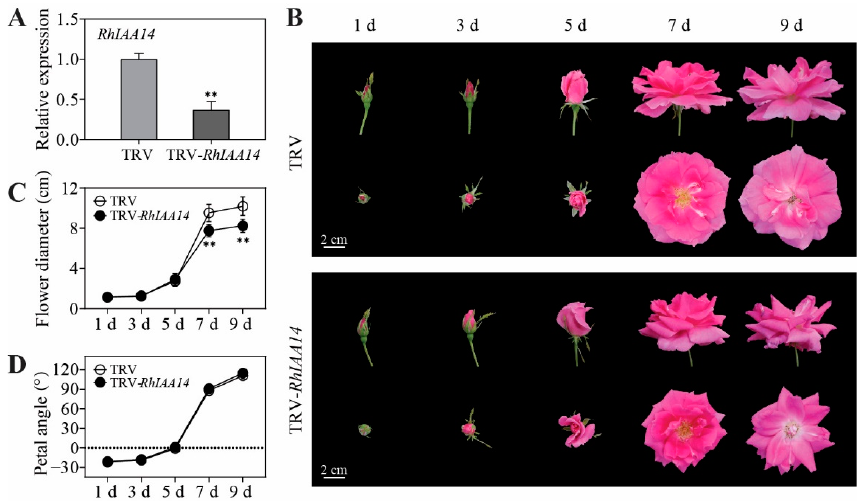
Figure 4. Flower phenotypes of silenced RhIAA14 . ( A ) Expression of RhIAA14 in RhIAA14 -silenced and TRV control petals. TRV, empty vector; TRV- RhIAA14 , TRV containing a fragment of RhIAA14 . RhUBI2 was used as an internal control. ( B ) Phenotypes of TRV and TRV- RhIAA14 flowers were recorded every other day. Day 1, flower buds with loose sepals. Bar = 2 cm. ( C , D ) Quantitative statistics of phenotypes. Flower diameter ( C ) and petal angle ( D ) of RhIAA14 -silenced plants and TRV controls were measured every other day. The results are the mean of three biological replicates ± SD, and asterisks indicate significant differences, in accordance with Mann–Whitney U-test (** p < 0.01).